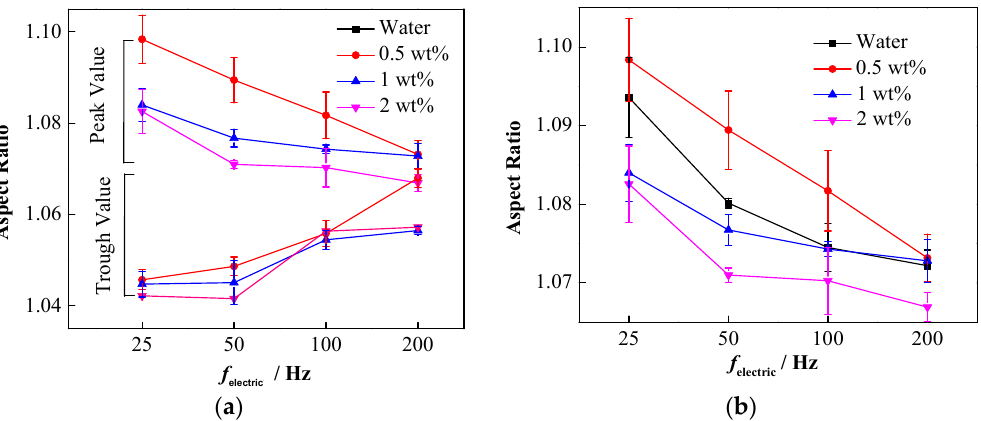
Figure 10. The variation of droplet oscillation amplitude under different particle concentrations and electric field frequencies. ( a ) Oscillation amplitude of nanoparticle-laden droplets; ( b ) oscillation peaks of droplets with different particle concentrations.